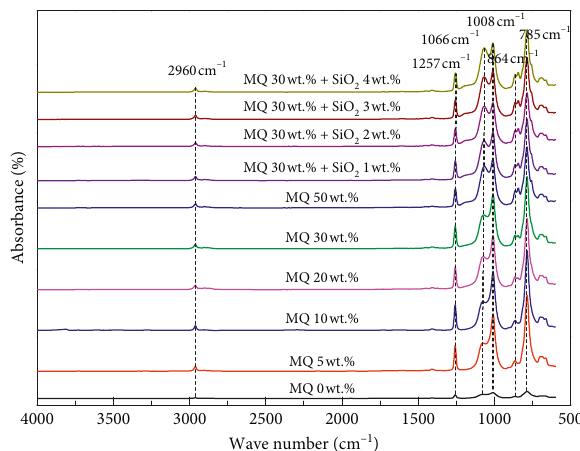
Figure 6: FT-IR spectra of coatings with different contents of methyl vinyl MQ silicone and nano-SiO